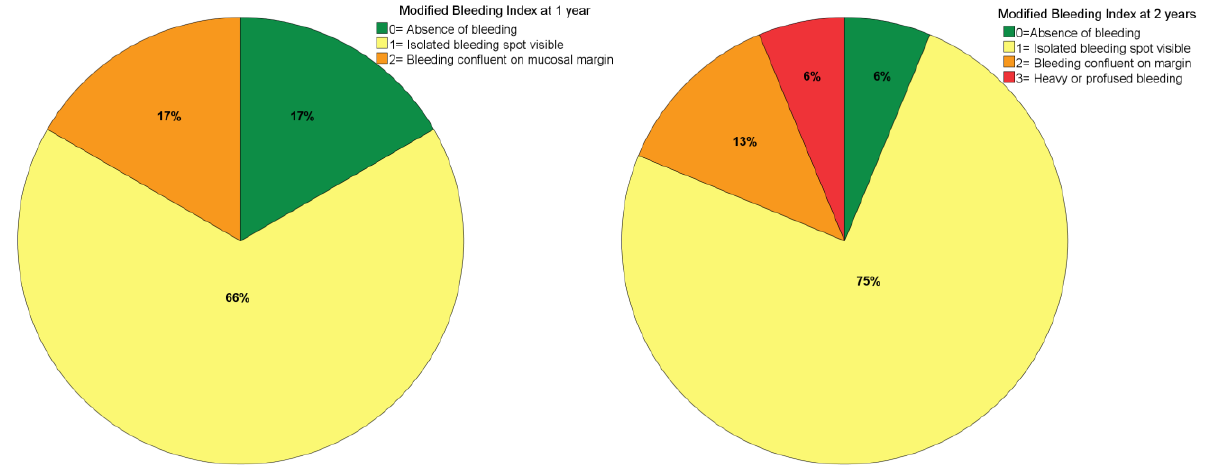
Figure 3. Plaque index levels at 1- and 2-years of follow-up.